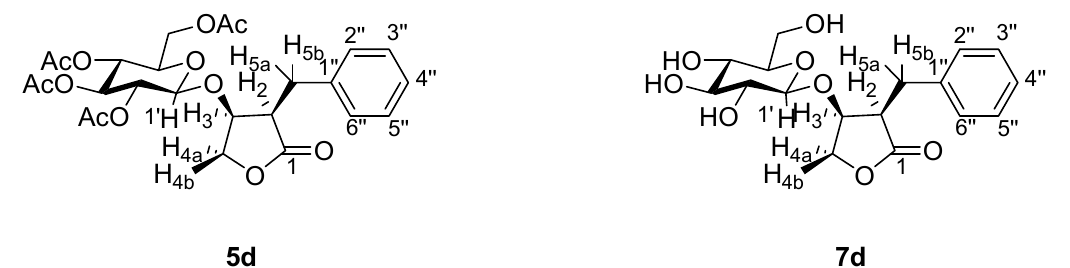
Figure 2. Structures of compounds 5d and 7d